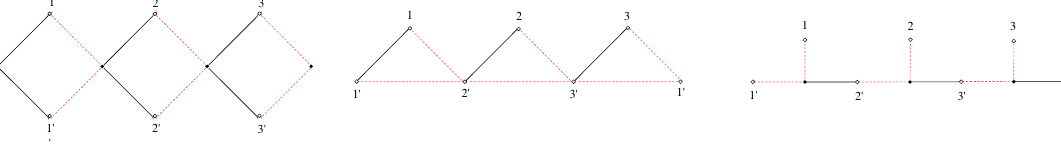
Figure 20 . Left: integral kernel of the transfer matrix operator t ( a ) ( u ) for a spin chain of length L = 3 , for spinless auxiliary space ‘ = ˙ ‘ = 0 and physical spaces in the Weyl fermion representation a a (3 / 2 , 0 , 1) . Center: the transfer matrix kernel at u → − 5 / 4 and θ = 0 takes the shape of a triangular lattice wrapped onto a cylinder. Right: by means of star-triangle duality the triangular lattice can be re-written as an hexagonal lattice of Yukawa vertices, where fermions propagate along the cylinder and scalar around